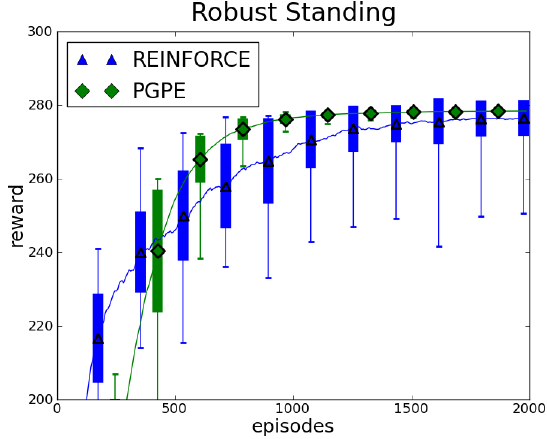
Figure 8. PGPEcomparedtoREINFORCEontherobuststandingbenchmark.